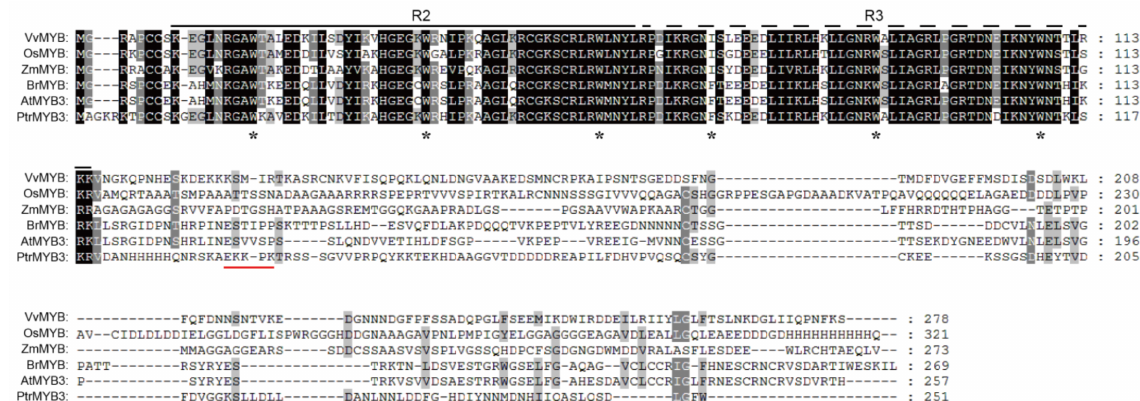
Figure 1. Multiple sequence alignment of PtrMYB3 and another five R2R3-MYB genes from five species, including Vitis vinifera (VvMYB, CBI20715.3), Oryza sativa (OsMYB, XP_015629423.1), Zea mays (ZmMYB, NP_001358856.1), Brassica rapa (BrMYB, XP_009115618.1), Arabidopsis thaliana (AtMYB, NP_564176.2). The R2 and R3 MYB domains are indicated with a black solid line and a dotted line, respectively. The conserved tryptophan (W) residues are indicated with asterisks (*). A nuclear localization signal (NLS) is indicated with a red solid line.